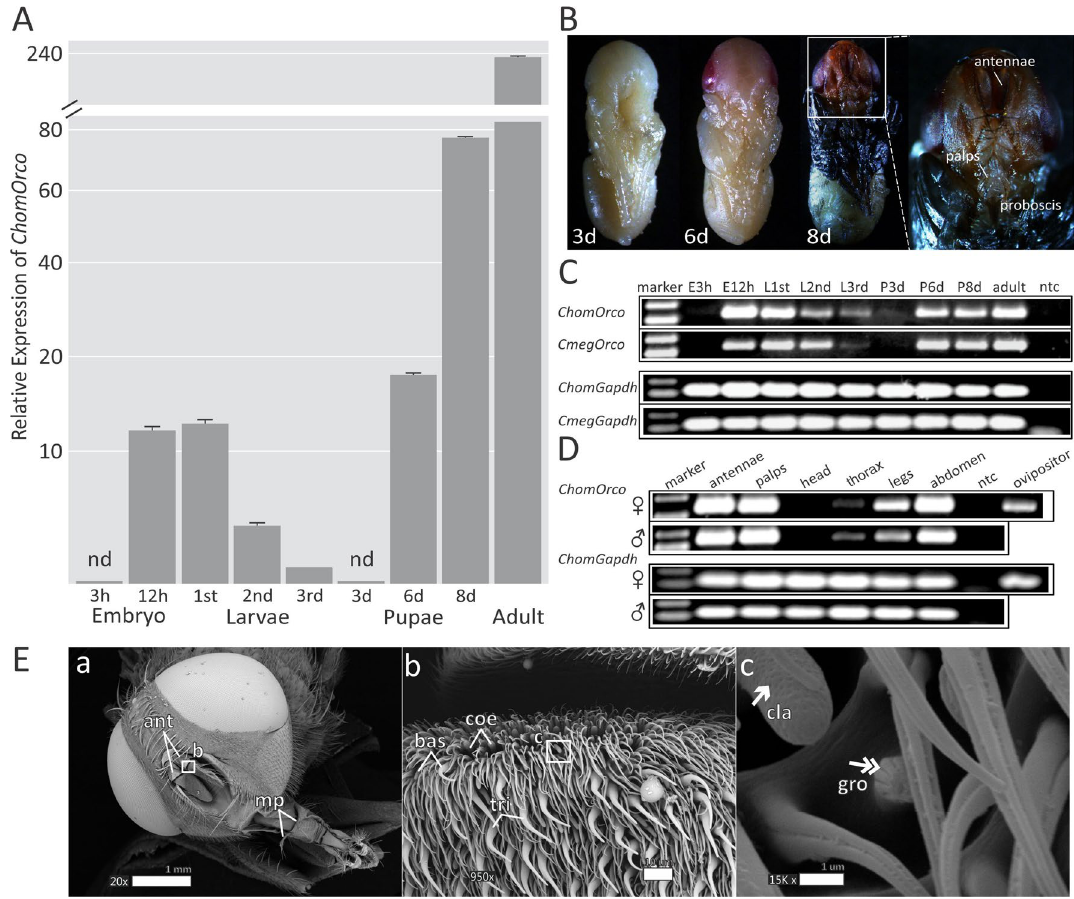
Figure 2. Expression of Orco is conserved among blowflies and broadly detected in chemosensory-related tissues of C . hominivorax adults. ( A ) Relative expression of ChomOrco during the screwworm development by qPCR. Measurements are given by the quantification of ChomOrco normalized to GAPDH using the 2 −ΔCt method and presented as fold-change relative to the third instar larvae using the 2 −ΔΔCt method. Data are represented as mean ± SD ( n = 9). Cycle thresholds above 35 were considered non-detected (nd). ( B ) Intrapuparial development of C . hominivorax at three (3d), six (6d), and eight days (8d) after pupation. A closer view of the head region (white square) reveals the fully developed sensory structures of the adult form present in the late pupae stage. ( C ) Semi-quantitative comparison between developmental Orco expression in C . hominivorax ( Chom ) and C . megacephala ( Cmeg ) species by RT-PCR. ( D ) Detection of ChomOrco in adult screwworm female ( ♀ ) and male ( ♂ ) tissues. For all RT-PCR assays: Amplifications were made in replicates ( n = 3), including no template controls (ntc), and GAPDH was amplified as an internal control. Cropped images (delineated by black lines) are from samples run on different gels. Full-length gels are displayed in Supplementary Fig. S2. ( E ) The main olfactory structures of C . hominivorax viewed under electron microscopy. ( panel a ) Screwworm female’s head highlighting the antennae (ant), and the maxillary palps (mp). ( panel b) A closer view of the proximal surface of the third antenna segment reveals a number of tricoide (tri), basiconic (bas), and two morphotypes of coelonic (coe) sensilla ( panel c ), named grooved (gro) and clavate (cla). These morphotypes are adorned with multi-wall pores (single arrows) and grooves (double arrows), which presumably facilitate the entrance of odor molecules into the Expression of Orco is conserved among blowflies and broadly detected in chemosen‑ sory‑related tissues of C. hominivorax adults. We investigated the relative expression of Orco during screwworm development by quantitative real-time PCR (qPCR). Results revealed that Orco transcription takes place during the final stages of embryogenesis (12 h after oviposition when eggs are incubated at 37 ± 2 °C), and its expression is maintained at similar levels during the first instar larvae stage (Fig. 2A). The ChomOrco expression decreases in the subsequent larval development, reaching the lowest levels in the third larval stage. The pupal stage is characterized by a gradual increase in Orco transcript abundance over time (3-to-8-days after pupation; Fig. 2A), reaching its highest level during the pre-imago development (8-days after pupation). Upon dissection (Fig. 2B; Supplementary Methods), it was possible to verify that the full development of the adult form and their main olfactory appendages occurs in this last pupal stage, which is synchronized with ChomOrco expression. In the adult stage, the ChomOrco transcription reaches its highest level. These observations are con- sistent with the idea that Orco expression follows the transition from a primordial larvae sensory system to more